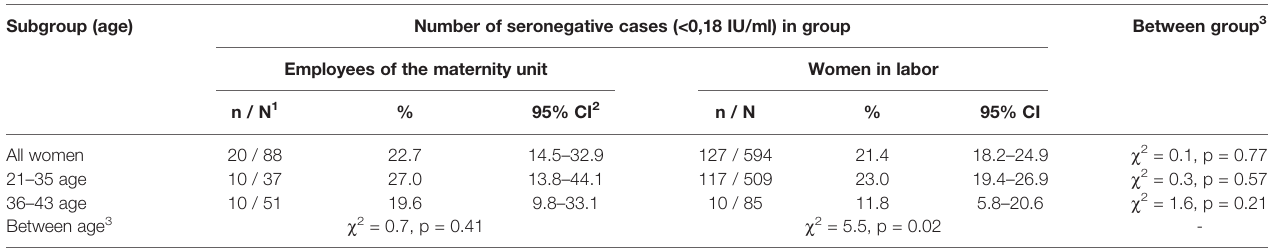
TABLE 1 | Comparison of the shares of seronegative to the measles virus persons among the maternity unit employees and women in labor. Subgroup (age) Number of seronegative cases (<0,18 IU/ml) in